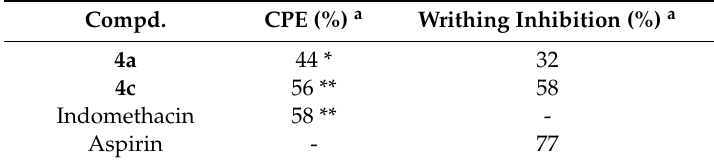
Table 2. In vivo anti-inflammatory and analgesic activities of 4a and 4c . % inhibition of carrageenin-induced rat paw edema (CPE%) and % inhibition of writhing responses (writhing inhibition%). Compd. CPE (%) a